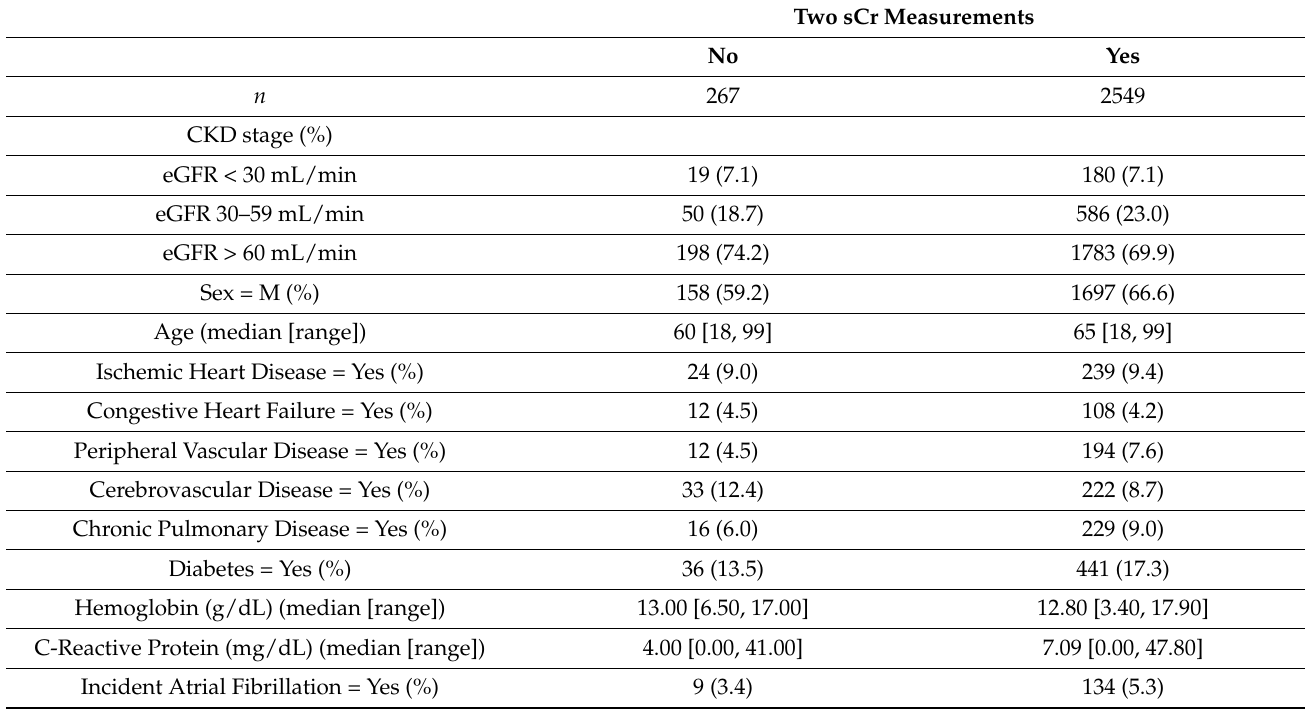
Table A5. Differences between patients with a single creatinine measurement and the rest of the